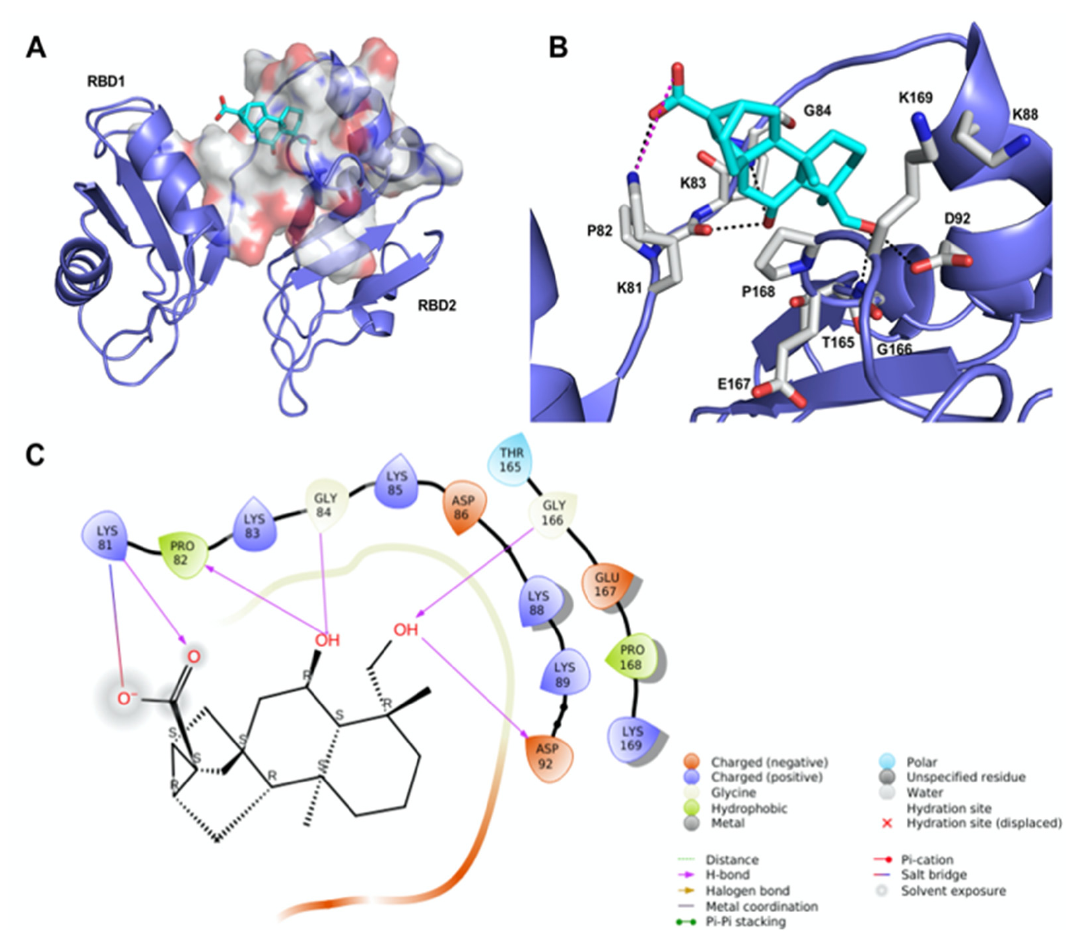
Figure 2. Theoretical binding mode of compound 12 to RNA-binding domains 1 and 2 (RBD1,2) of nucleolin. ( A ) The best-scored pose of compound 12 (cyan sticks) within RBD1,2 represented as a slate ribbon model. The site identified by SiteMap is represented as a white Connolly surface. ( B ) Close-up view of compound 12 docked pose. Only amino acids located within 4 Å of the bound ligand are displayed (white sticks) and labeled. The H-bonds discussed in the text are depicted as dashed black lines; the salt bridge is depicted as a dashed magenta line. ( C ) Two-dimensional ligand interaction diagram of compound 12 ’s docked pose.